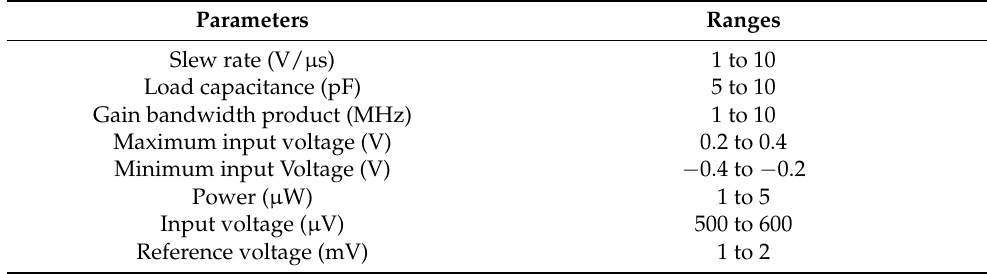
Figure 5. Convergence plots for the implemented metaheuristic algorithms. Table 1. Ranges for the design variables.